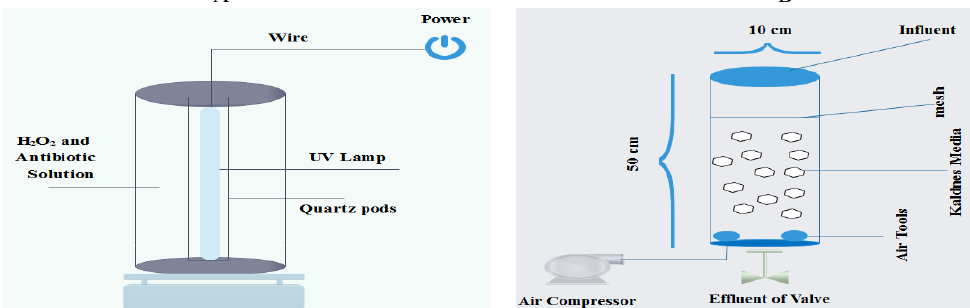
Fig. 1 Pilot schematic A) UV/H 2 O 2 and B) MBBR